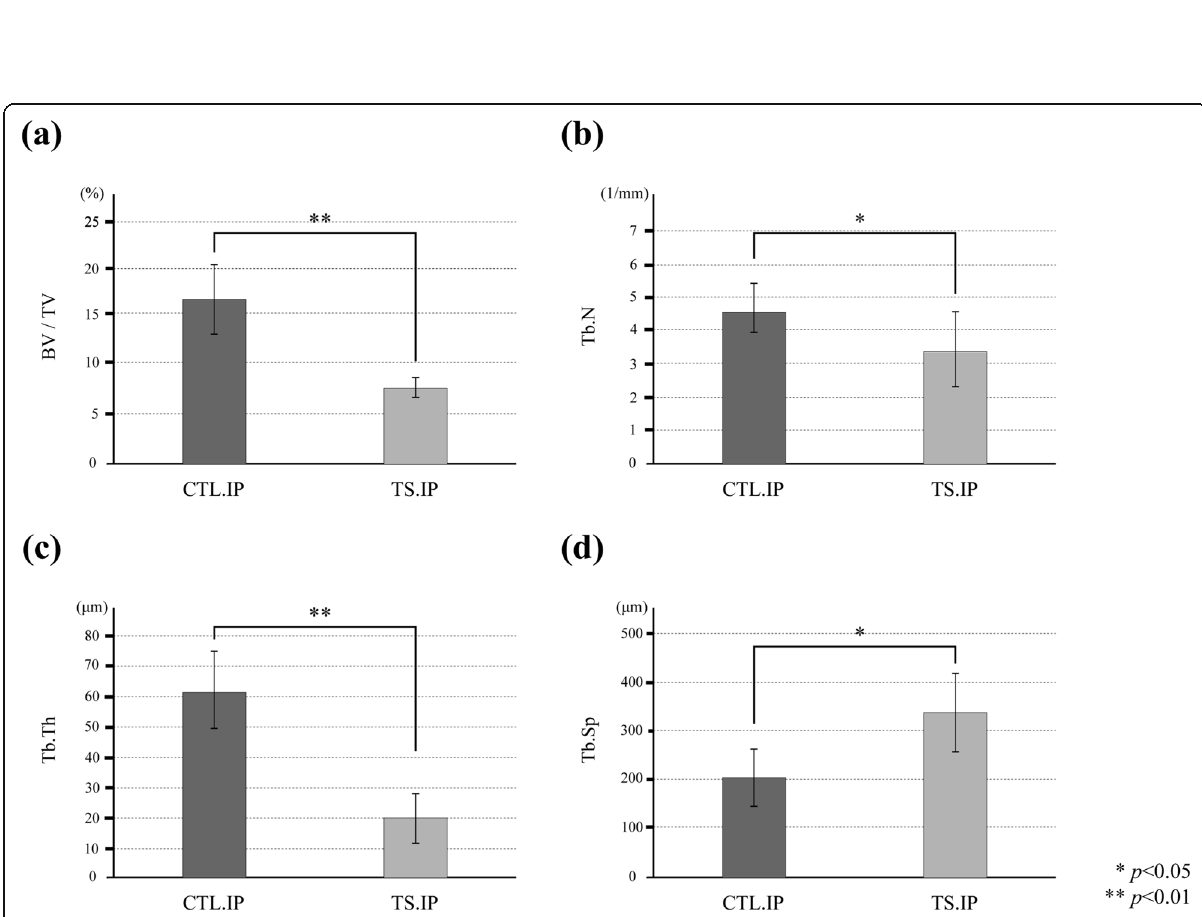
Fig. 8 Morphometric evaluation of cancellous bone. a BV/TV. b Tb.N. c Tb.Th. d